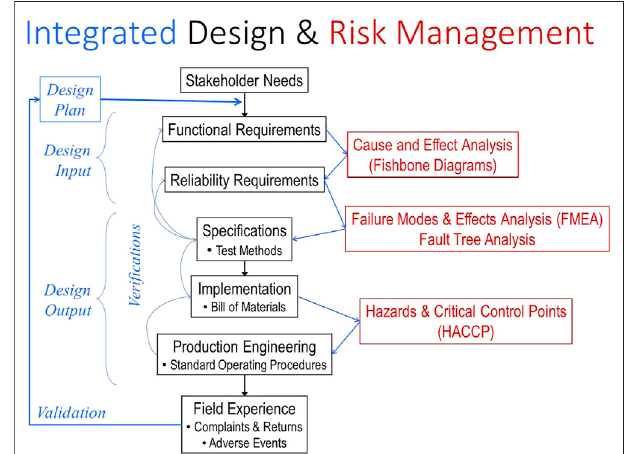
FIGURE 2 | The steps in the FDA-mandated Design Control process (center section in black) must be informed by various Risk Management tools (right section in red) and integrated, veri fi ed and documented (left section in blue). Whenunanticipated complaints and failures occur in the fi eld, they often mandate expensive and lengthy recalls and remediation of the product. They also represent a failure to validate the design control and quality processes, which should then be modi fi ed to prevent similar failures with future